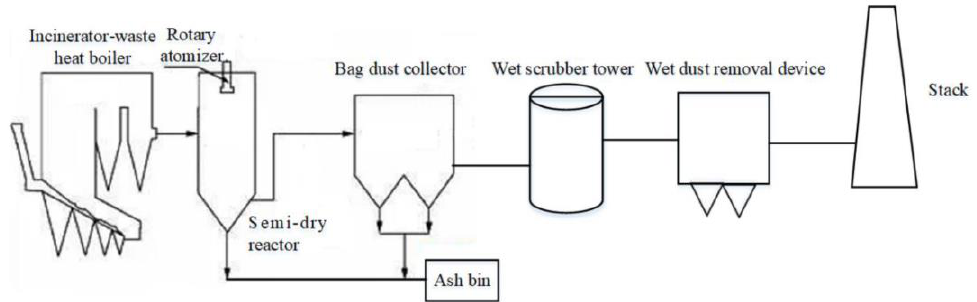
Figure 3. Simple flow chart of a modified flue gas purification